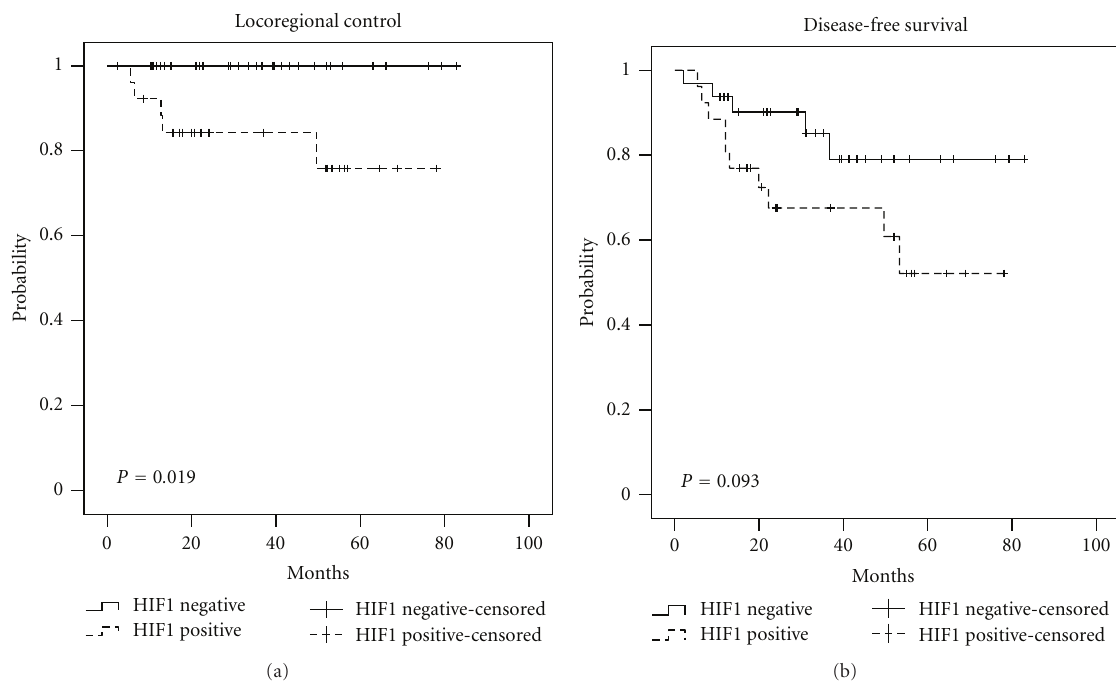
Figure 4: Locoregional control and disease-free survival stratified by HIF-1 α (nuclear)